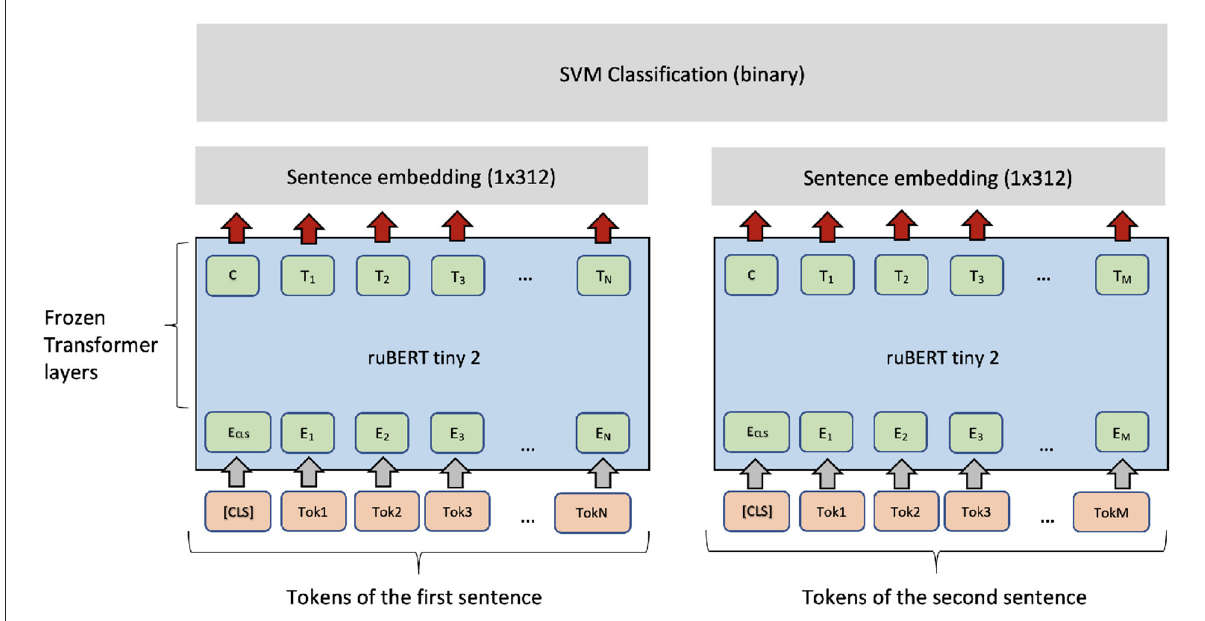
FIGURE5 SVM + ruBERT-tiny2 architecture for classification and regression for sentence